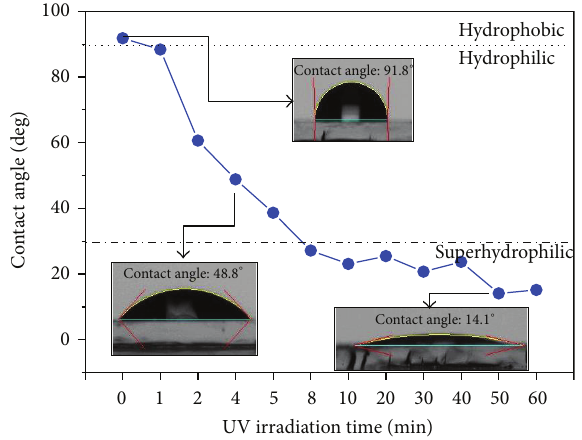
Figure 5: Schematic diagrams illustrating the ZnO films with differ- ent scales of grain size induced by different deposition powers: (a) nanograin (50 and 75 W), (b) mixed nanograin and submicrograin (100W), and (c) submicrograin (150 W) types, respectively.